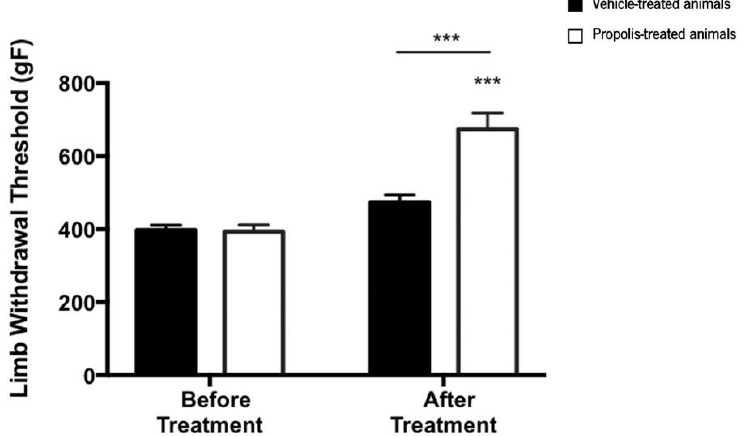
Figure 6. Evolution of the limb withdrawal threshold (LWT) in the right knee of ethanol (vehicle) and propolis-treated animals. The LWT was measured using the PAM test and the results were expressed as mean ± SEM (*** p < 0.001; *** above the bar is related to before the treatment of the same tested group) ( ◼ — vehicle-treated animals; — propolis-treated animals).